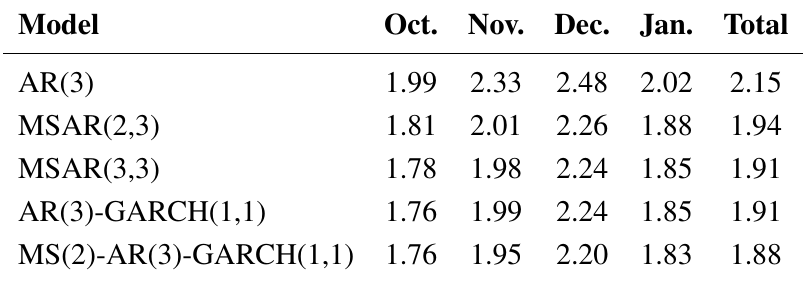
Table 6. CRPS criterion given in percentage of the nominal capacity of the Horns Rev 1 wind farm. Results are given for the same models as for the point prediction